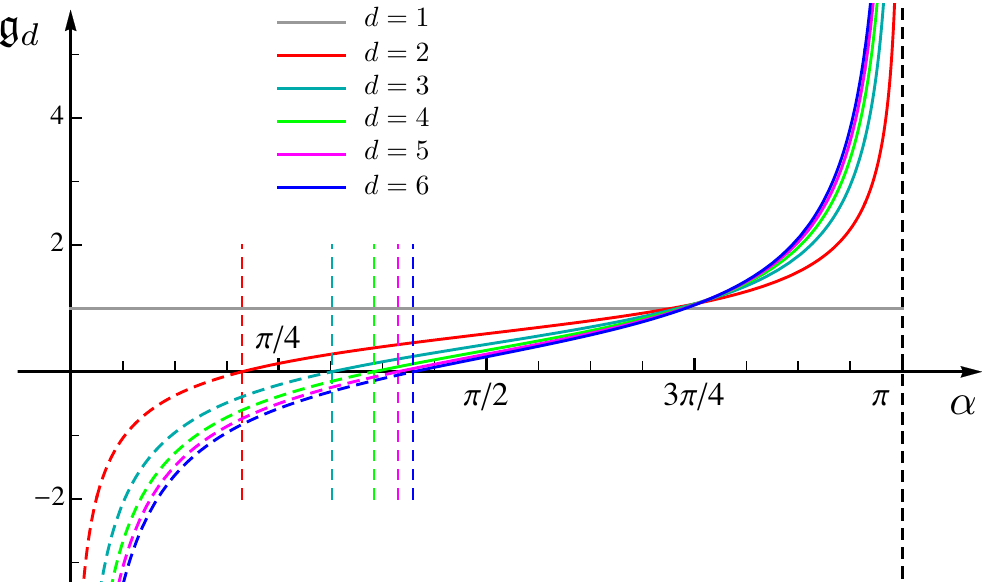
Figure 22 . The function g d ( (cid:11) ) de(cid:12)ned in (C.11) for some values of d . For a given d , the critical value (cid:11) c ( d ) is the unique zero of g d ( (cid:11) ) (see (C.13)) and it has been highlighted through a vertical dashed segment having the same colour of the corresponding curve g d ( (cid:11)